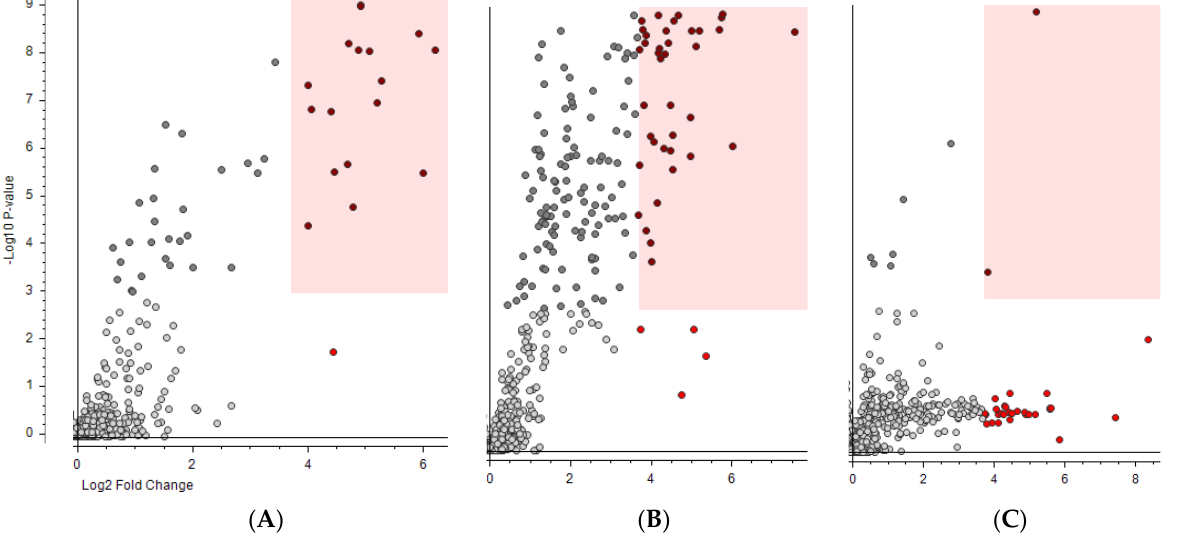
Figure 7. Differential analysis in order to reveal any unexpected compound as described in Section 3.4: ( A ): The DWTP effluent was used as reference. ( B ): The second reservoir was used as reference. ( C ): Both the DWTP effluent and the second reservoir were used as references. The red shaded area corresponds to criteria set only for the purpose of comparison of ( A – C ) (Log2 Fold Change > 3.7, p - value < 0.001). (Only compounds with a positive Fold Change are shown, i.e., compounds having a higher concentration in the suspected sample).